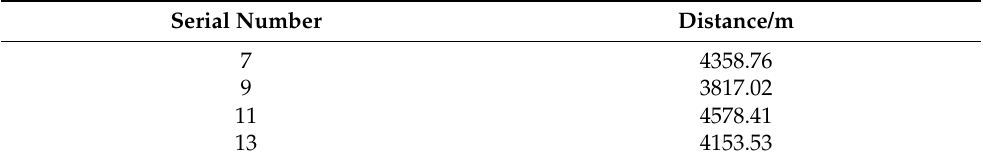
Table 7. The total distance to traverse the center of gravity of all sub-regions in the four